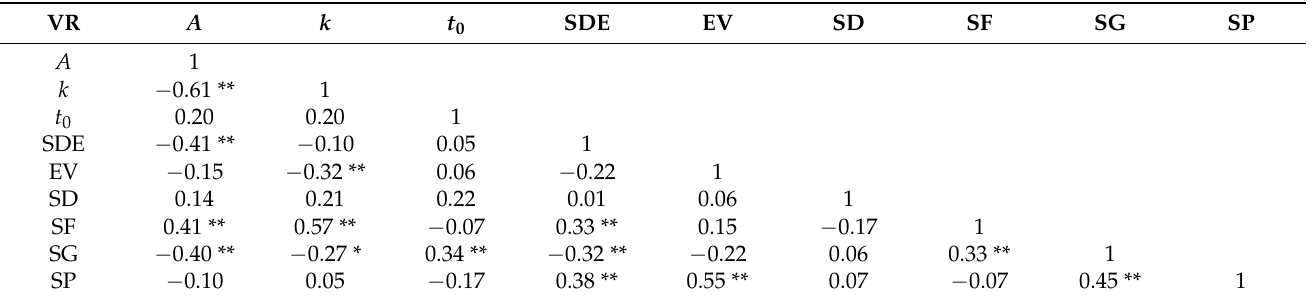
Table A4. Spearman’s partial rank correlation matrix between height–age curve parameters and topographic conditions. Variable (VR). Height–age curve parameters as upper limit of growth ( A ); curvature of tree growth curve ( k ); time lag of tree growth ( t 0 ). Stand density (SDE). Elevation